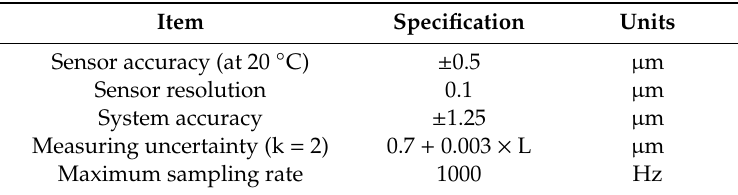
Table 3. Ballbar QC20-w specifications [33].